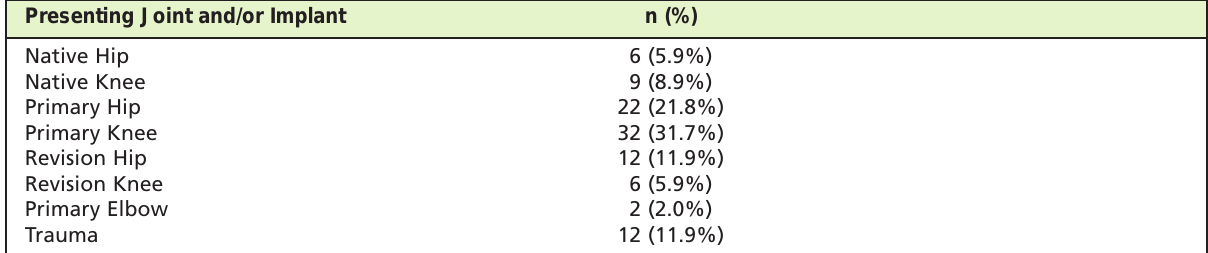
Breakdown of the presenting joint and/or implant at presentation to PJI MTD meeting Table I: Presenting Joint and/or Implant